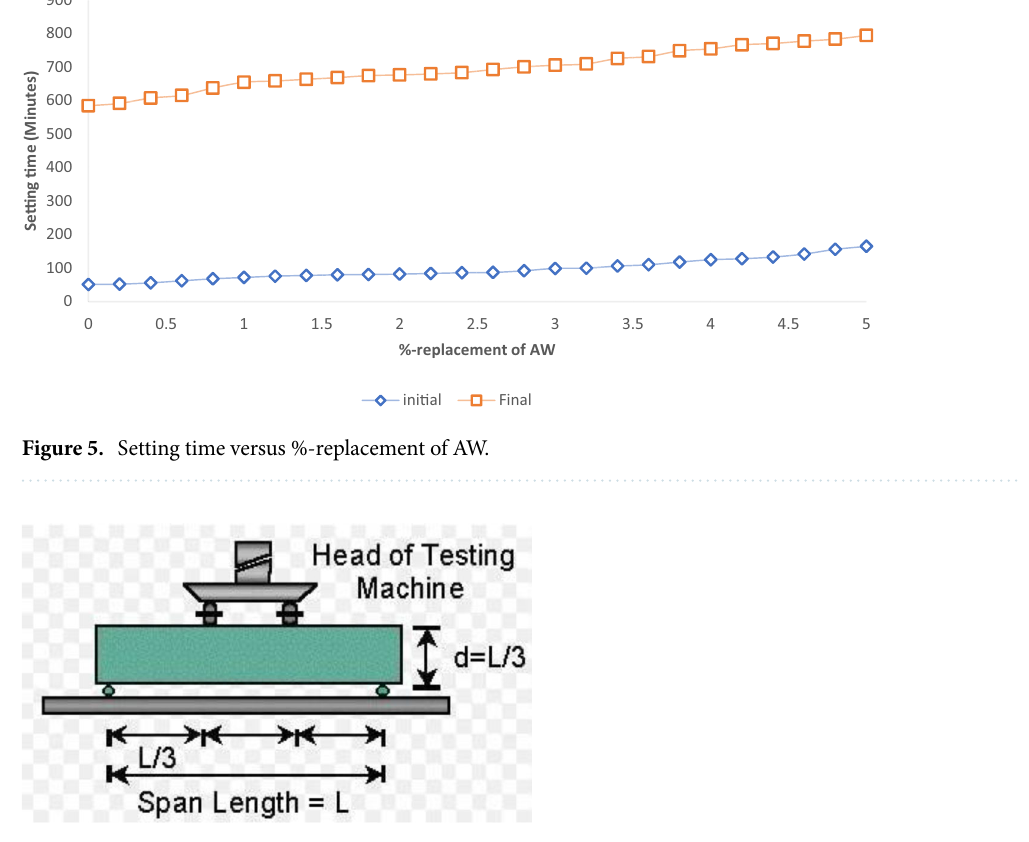
Figure 6. Loading configuration: four-point load flexural test (ASTM C78).